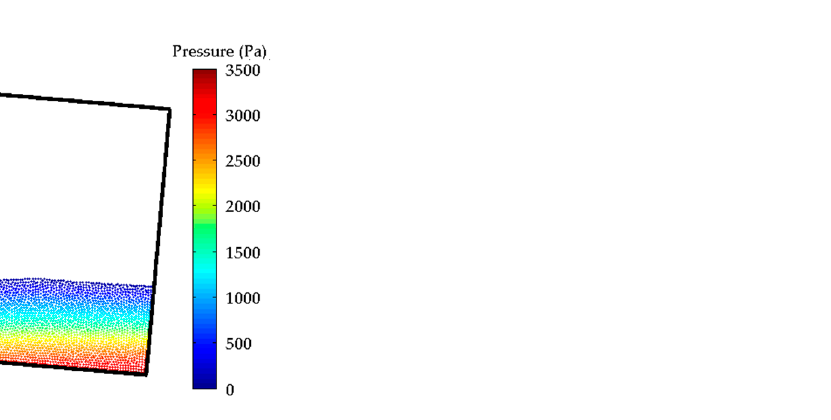
Figure 19. Flow pattern and pressure distribution in the SPH simulation